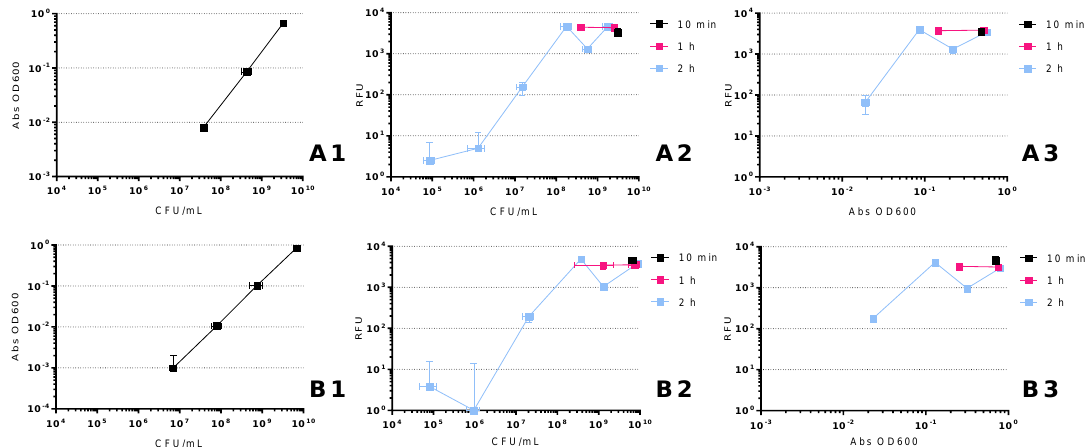
Figure 1. Relationship between optical density and viable counts ( 1 ), fluorescence after 10 min, 1 h and 2 h of incubation and viable counts ( 2 ) and fluorescence after 10 min, 1 h and 2 h of incubation and optical density ( 3 ) of overnight cultures of E. coli ( A ) and S. Typhimurium ( B ). Optical density is expressed in absorbance (Abs OD 600 nm), fluorescence in relative fluorescence units (RFU) and viable counts in colony-forming units per milliliter (CFU/mL). The values are expressed as the means of three independent experiments; error bars indicate the standard deviation. Some values are missing because they go below the method’s lower detection limit and would go to a negative Y value, and negative numbers cannot be shown on a logarithmic axis.